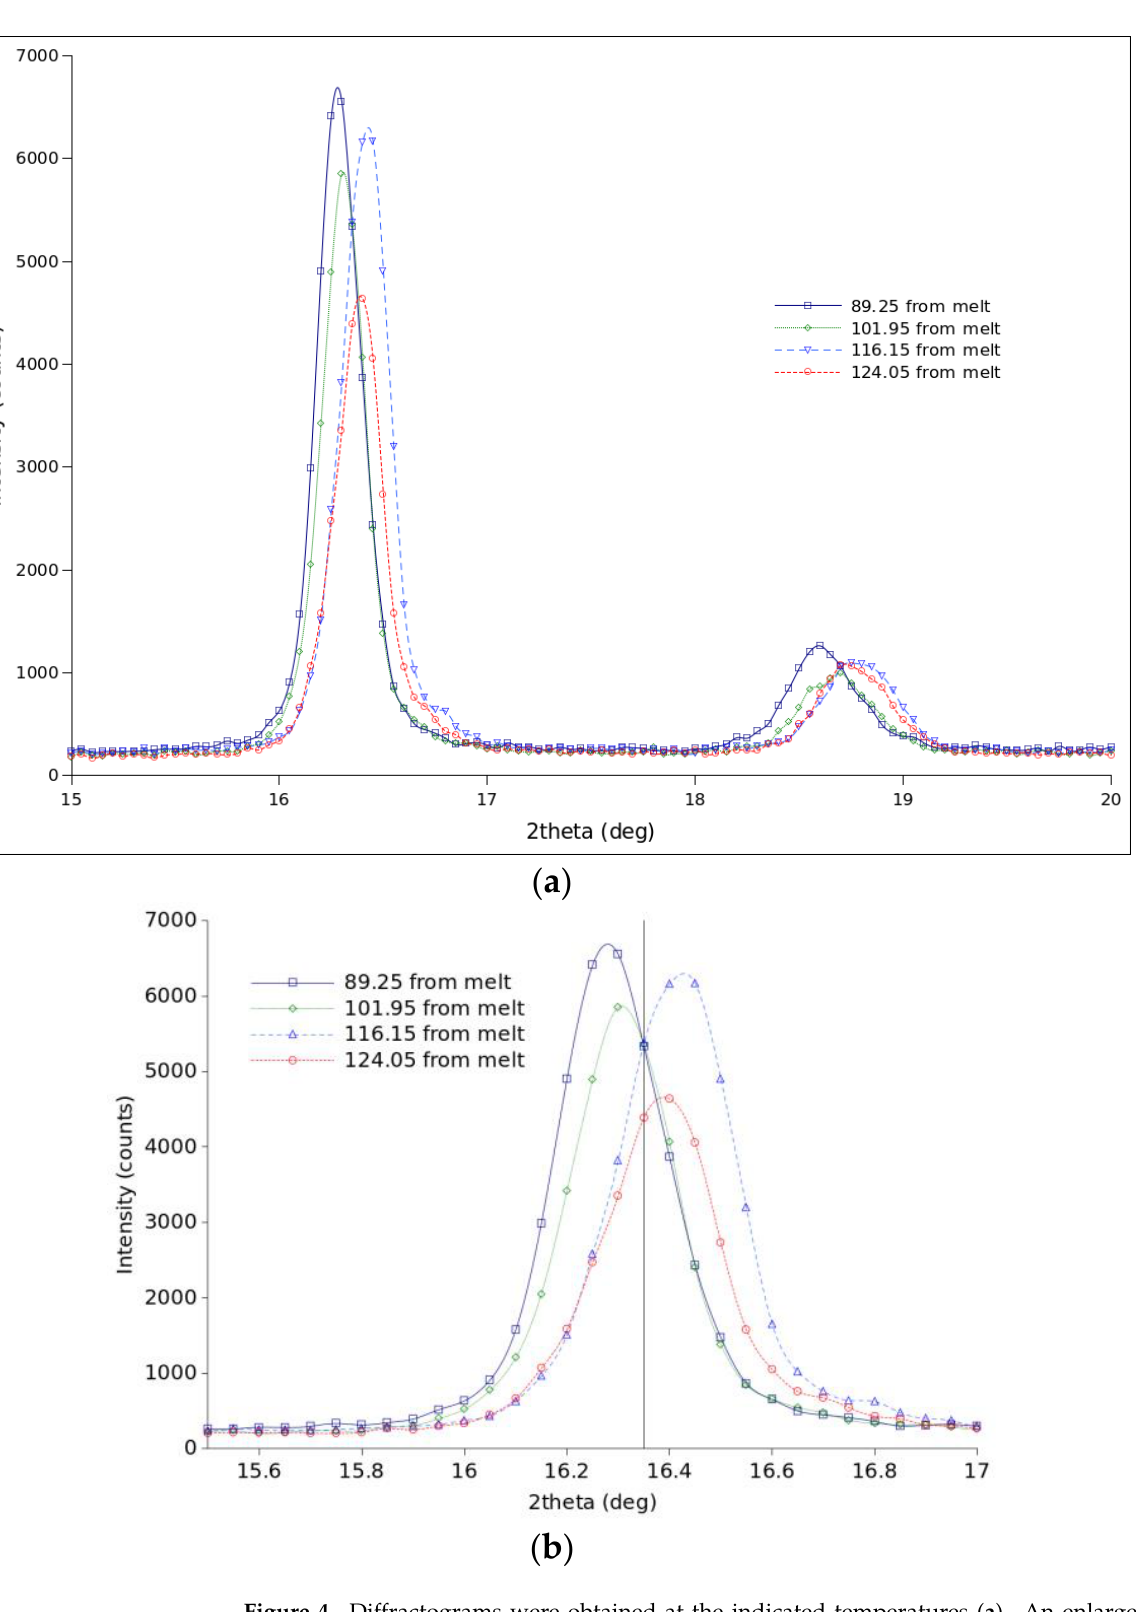
Figure 4. Diffractograms were obtained at the indicated temperatures ( a ). An enlarged area is displayed in ( b ).